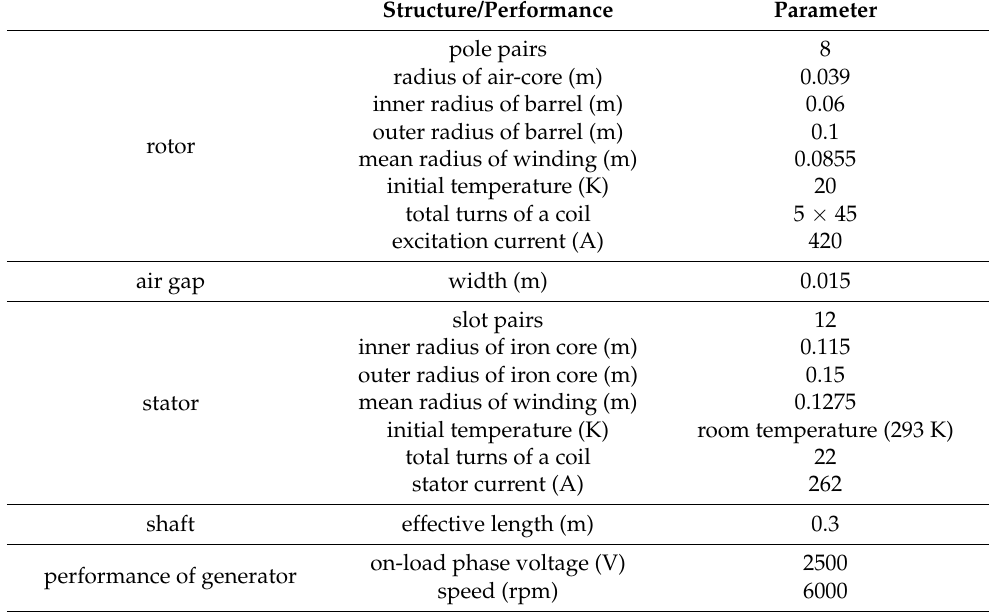
Figure 2. Structure of hybrid-HTS generator (without cooling system). Table 2. Initial design parameters of the generator.